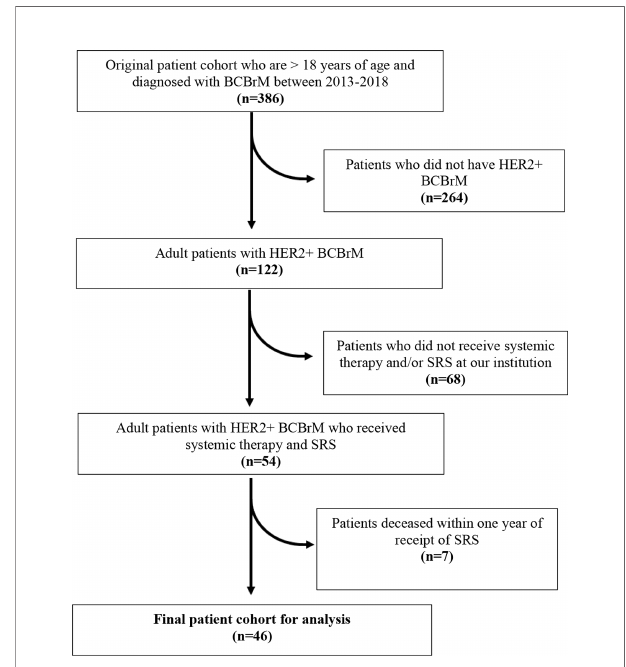
FIGURE 1 | Consort diagram of selection of patient cohort. Inclusion and exclusion criteria applied for derivation of fi nal sample